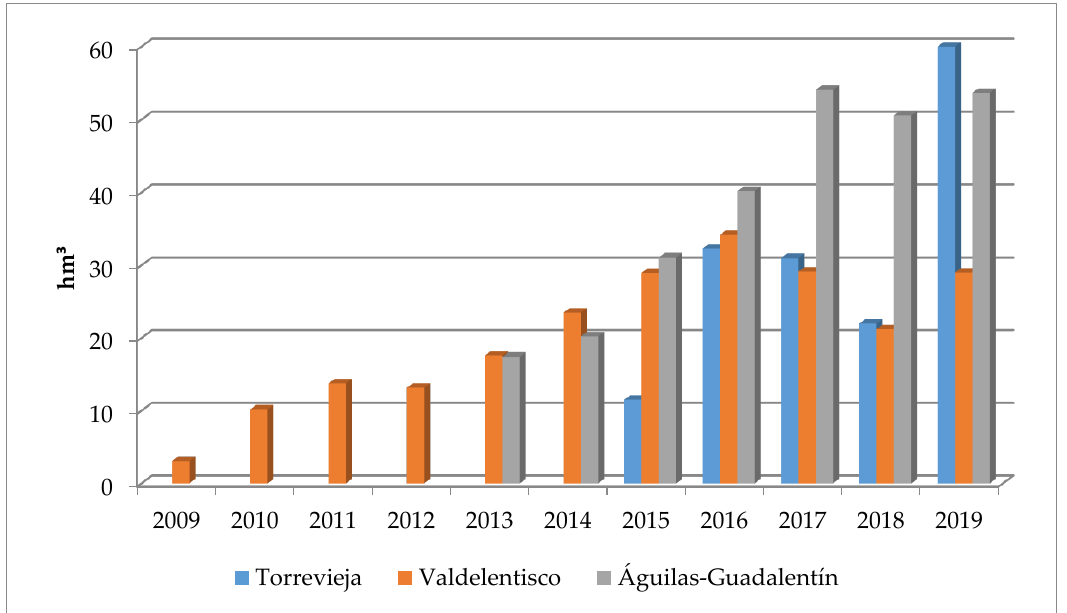
Figure 1. Desalination production for irrigation uses in Sociedad Estatal de las Cuencas Mediterráneas (ACUAMED) plants (2009–2019).